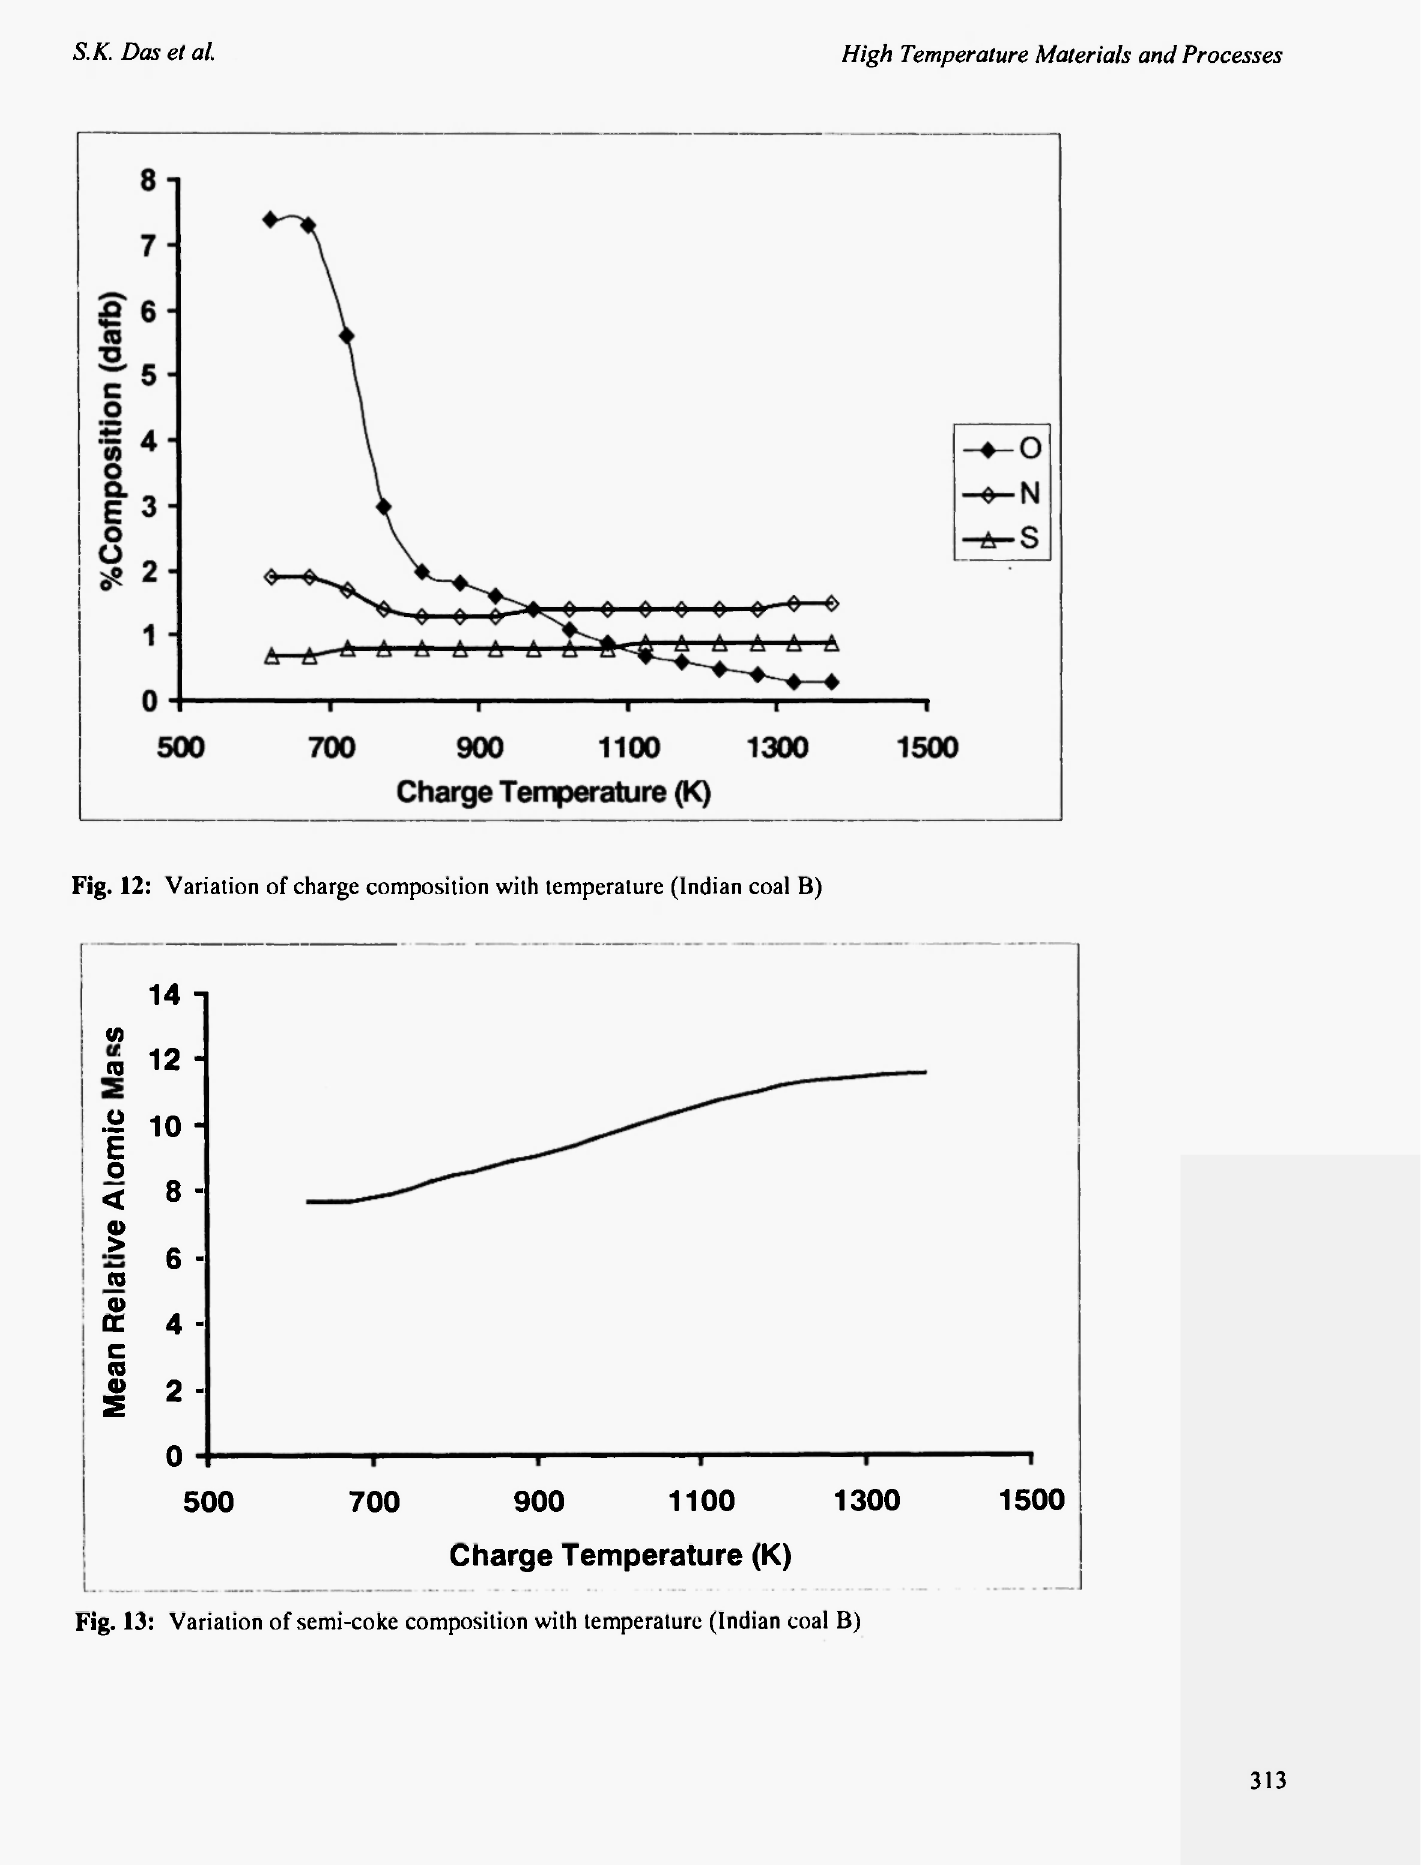
Fig. 13: Variation of semi-coke composition with temperature (Indian coal